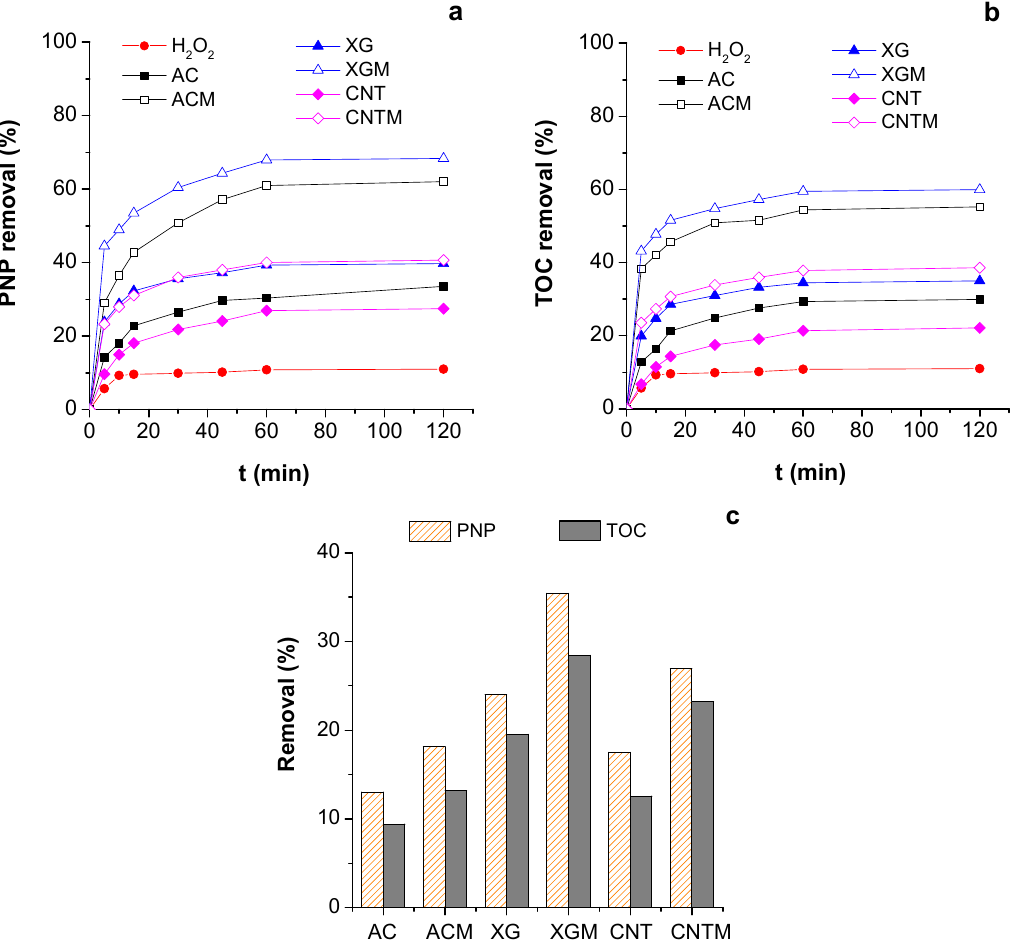
Figure 2. p -nitrophenol (PNP) ( a ) and total organic (TOC) ( b ) removal during catalytic wet peroxidation (CWPO) and adsorption, and PNP and TOC removals after 2 h for wet peroxidation only ( c ) using the carbon supports (pH = 3.0, T = 30 °C, [support] = 0.25 g L −1 , [H 2 O 2 ] = 29 mmol L −1 , [PNP] = 3.6 mmol L −1 and H 2 O 2 :PNP molar ratio = 8.1).